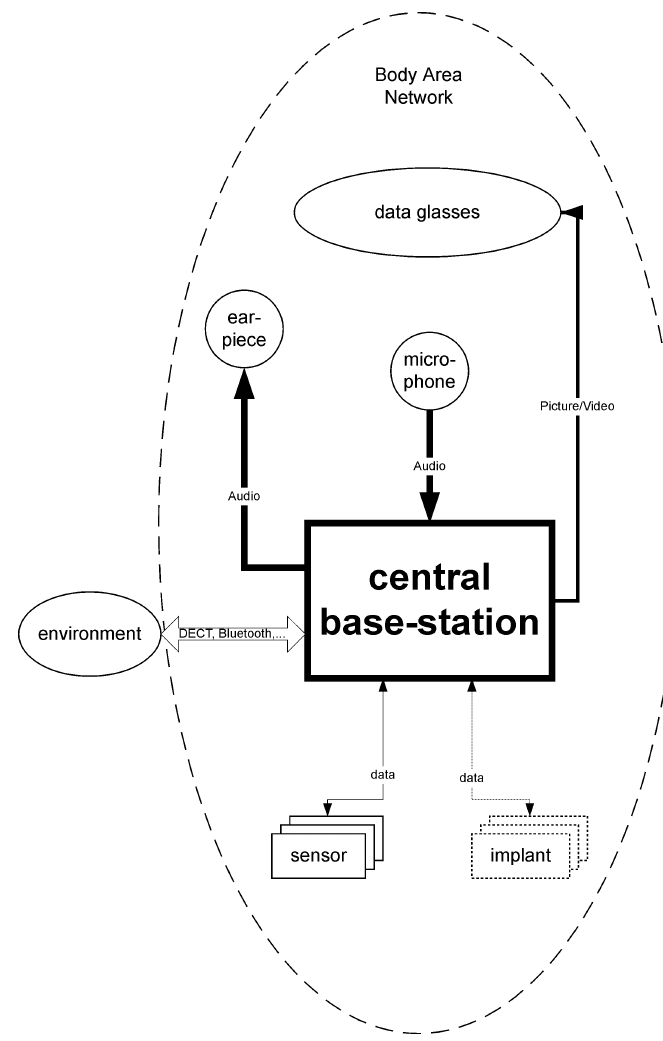
FIGURE 1 Possible parts within a body area